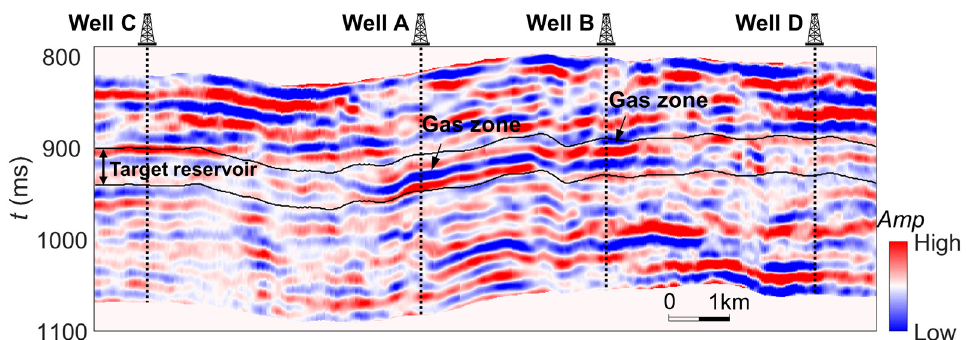
Figure 11. Seismic profile across wells A, B, C, and D (well locations shown in Figure 10). The two black lines indicate the interpreted tight sandstone gas reservoirs.